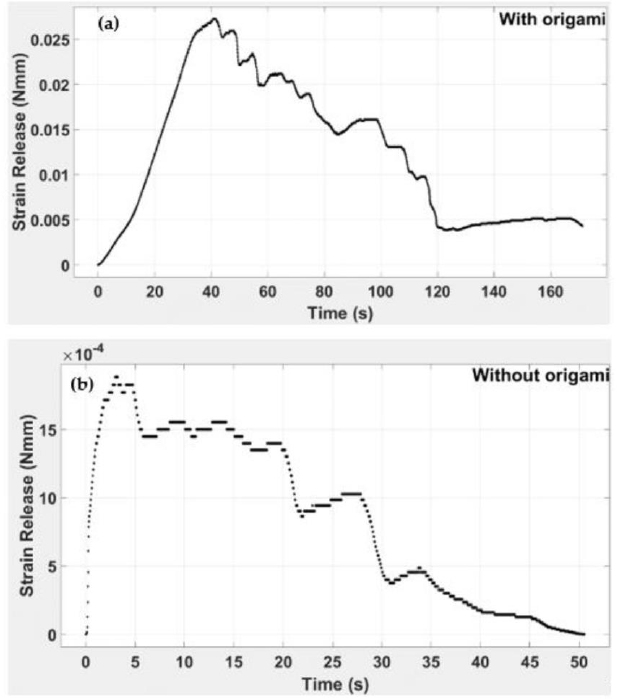
Figure 24. Strain release vs. time for DCB ( a ) with origami capsule and ( b ) without